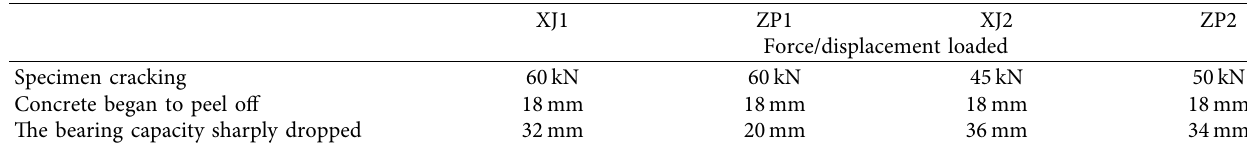
Figure 4: Test results. (a): XJ1 (A) and ZP1 (B). (b): XJ2 (A) and ZP2 (B). Table 2: Test results of